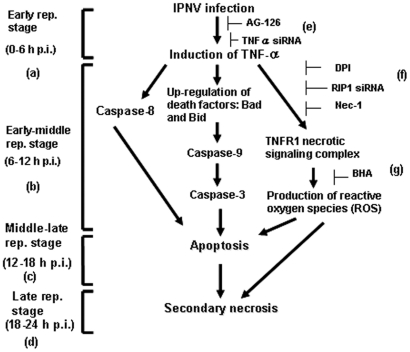
IPNV induces apoptotic and necrotic death cascades via TNFα induction.A hypothesis of how pro-inflammatory TNFα is up-regulated by IPNV infection and how it regulates the apoptotic and necrotic death pathways. When a cell is infected with IPNV (E1-S), the virus binds to the cellular receptor, penetrates the cell, uncoats (the entry stage), and up-regulates the expression of TNFα (a) during the early replication stage (0–6 h p.i.). This up-regulation of TNFα regulates the next wave of gene expression, including the pro-apoptotic genes bad and bid, during the early-middle stage of replication (6–12 h p.i.; b), at which point the TNFR necrotic signaling complex and reactive oxygen species (ROS) are produced. During this stage, phosphatidylserine (PS) is externalized and endonuclease is released from the mitochondria, resulting in DNA restructuring and cleavage. Furthermore, the cell finally enters the post-apoptotic, necrotic stage during the middle-late stage of replication (12–18 h p.i.; c). During the late replication stage (18–24 h p.i.; d), the cells are broken down. The TNFα-mediated death signal is halted by treatment with a specific inhibitor of TNFα production. (e) TNFα-specific siRNA or AG-126, which block both the pro-apoptotic Bad/Bid-mediated death pathway and the TNFR/ROS-mediated secondary necrotic death pathway. (f) DPI, Nec-1 or RIP-1-specific siRNA, which block the activity of RIP-1 or Nox1 and block the formation of the TNFR necrotic signaling complex. (g) BHA blocks the formation of ROS.